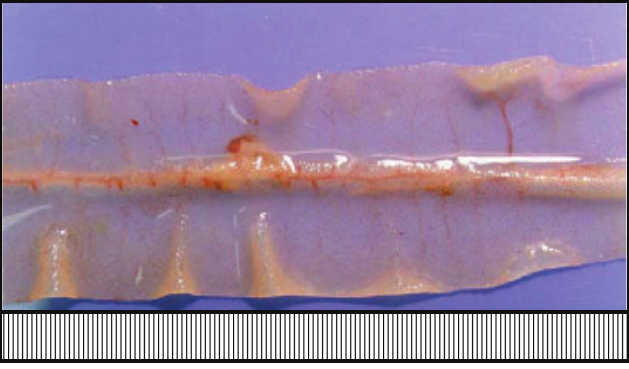
FIGURE 3 - Group IV – Day 4. Absence of lesions or scar